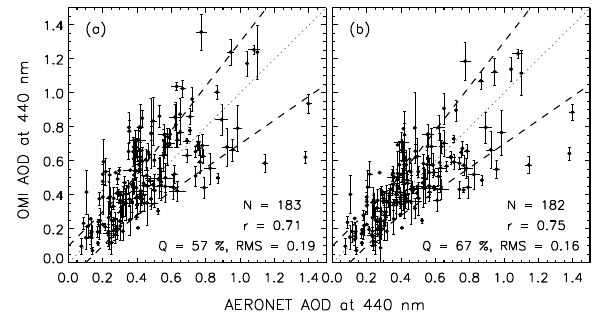
Fig. 7. Evaluation of AOD retrieval using standard aerosol layer height assumption (left) and CALIOP climatology (right) at the Banizoumbou